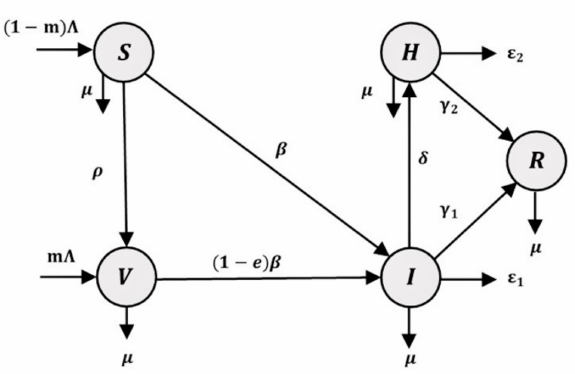
Figure 1. A flowchart of the susceptible-vaccinated-infected-hospitalized-recovered ( SVIHR ) model. The relationships among subgroups of the population represent the flow of people in each subgroup. Susceptible people are those in the population who are at risk of becoming infected with COVID-19. Therefore, a fraction of the susceptible group can become infected individuals and the rest could be vaccinated to protect against the disease. However, some vaccinated people are still susceptible to infection, but with a lower probability. Therefore, a proportion of vaccinated people could become infected people. In the flowchart of the population in the system, infected people represent the central component in the diagram. are infected and could be reduced when the infected people have moved into a hospital